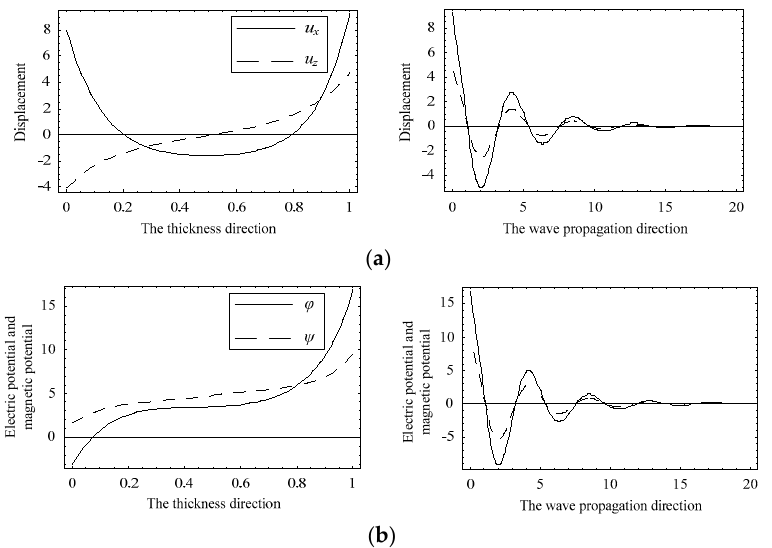
Figure 11. Distributions of the physical quantities when Ω = 1.01115, Ψ = 0.23216 − 0.04612i. ( a ) displacement distribution, ( b ) electric potential and magnetic potential distribution.